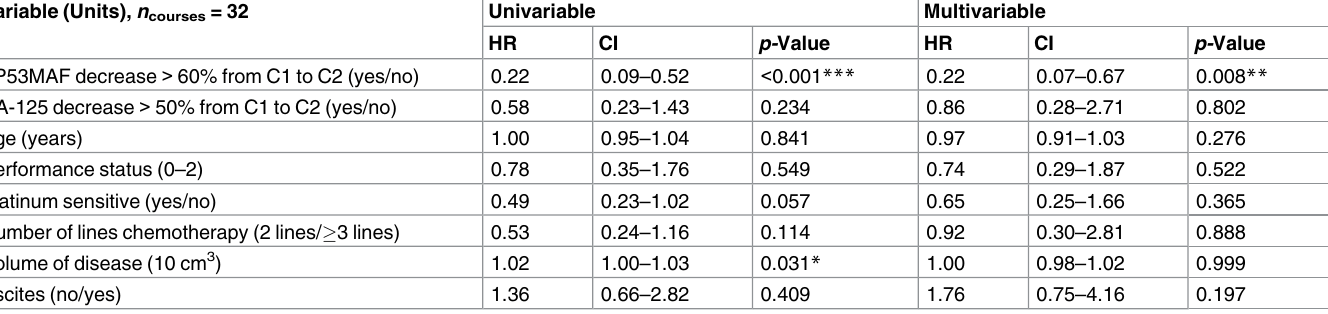
Table 3. Univariable and multivariable analysis of 60% decreasein TP53 mutant allele fraction after one cycle of chemotherapy as a predictor of time to progression. Variable (Units), n courses = 32